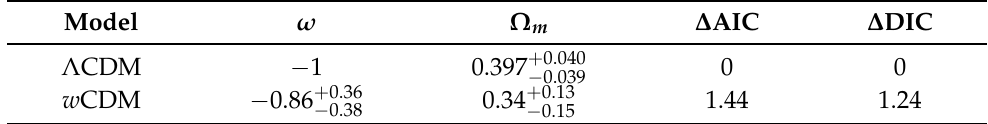
Table 7. 95% confidence level results of the MCMC analysis for the SN+GRB data. The AIC and DIC differences are intended with respect to the Λ CDM